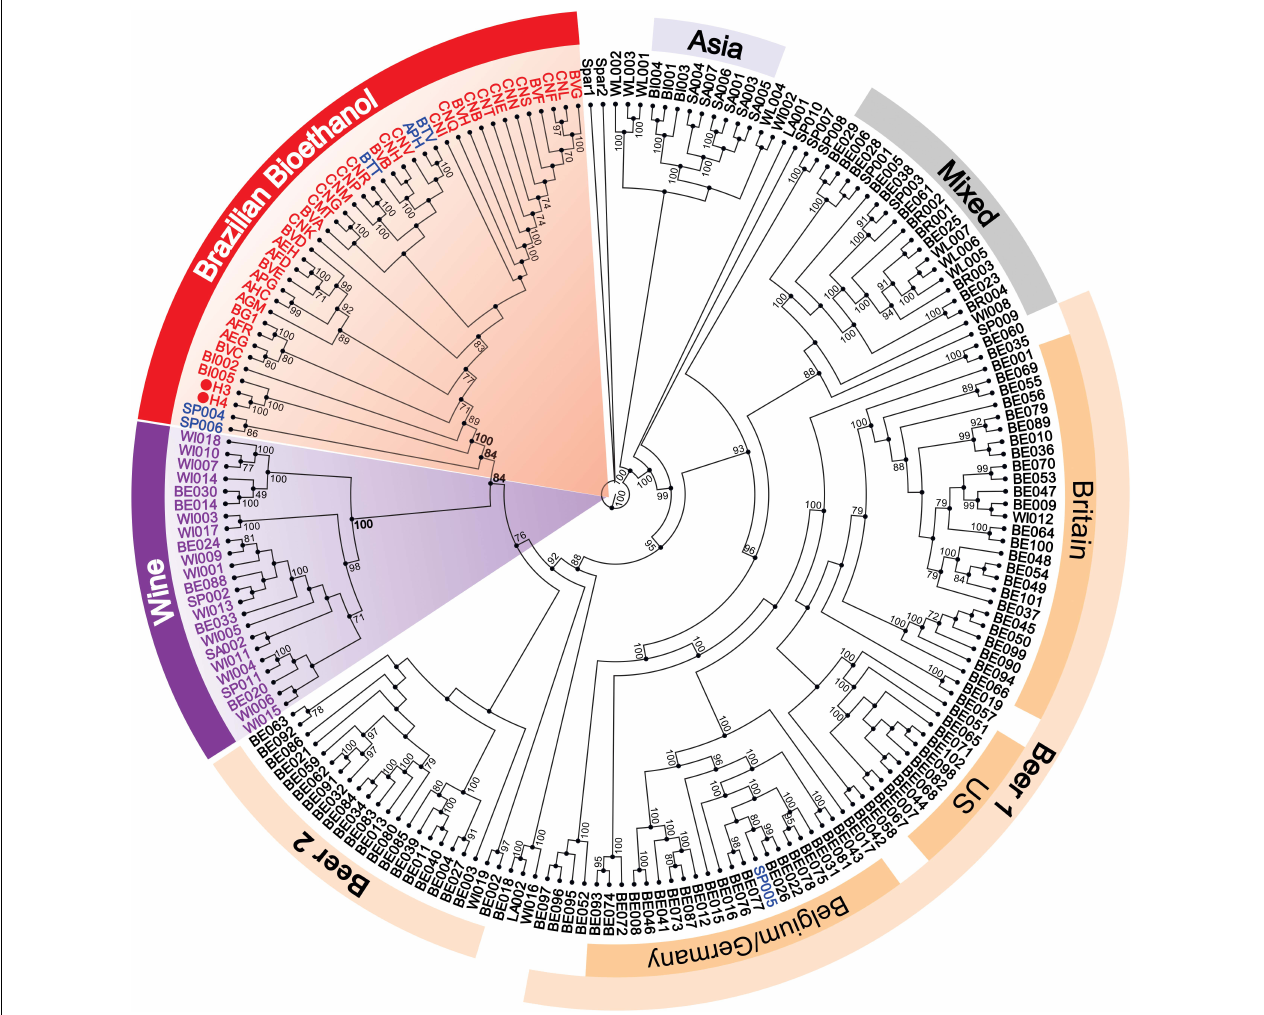
FIGURE 5 | AF-based phylogenetic tree of 197 yeasts genomes. A distance matrix was calculated based on an AF approach and used to build a NJ phylogenetic tree. The Brazilian bioethanol group (red) was clustered in a single clade, with the exemption of the cachaça strain SP005. In addition, five major clades were resolved in accordance to Gallone et al. (2016) and are indicated with different colors. H3 and H4 are indicated with red circles. Cachaça strains are labeled in blue. Node support was derived based on 100 jackknife pseudo-replicates. Only support numbers above 70 are